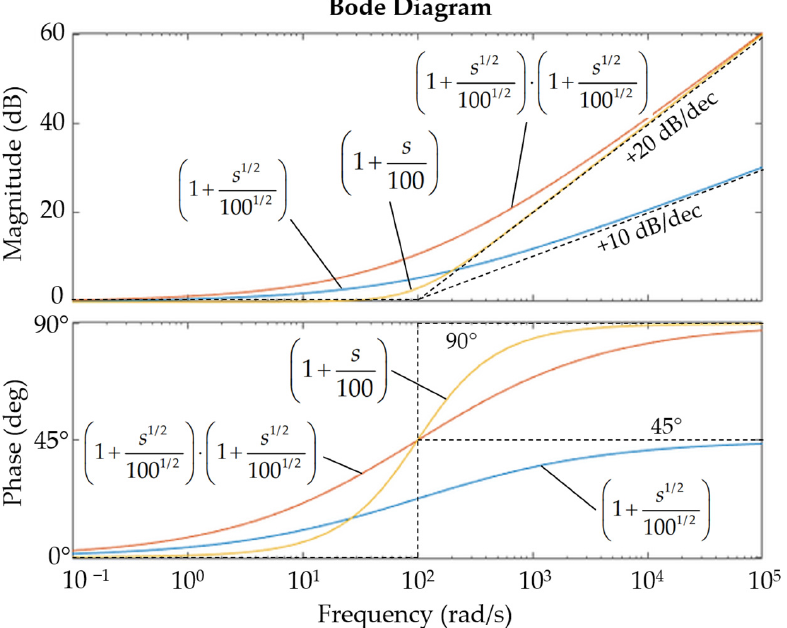
Figure 9. Bode plots of: a half-zero term with corner frequency of 100 rad/s (blue); two half-zero terms with corner frequency of 100 rad/s (red); a zero term with corner frequency of 100 rad/s (yel- low).